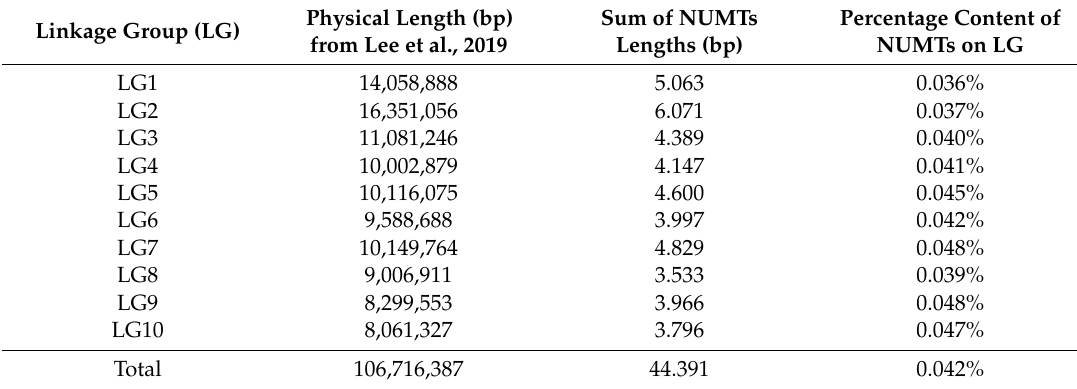
Table 1. Percentage content of NUMTs in the linkage groups of the nuclear